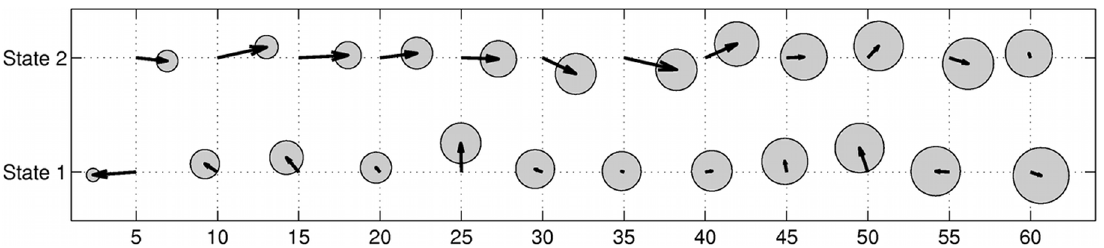
Figure 3. Posterior mean vectors of turning-angle distributions of possum # 1882. The figure shows the posterior mean vectors of the wrapped Cauchy distribution of turning angles, for each sub-sampling interval and behavioural state. Circles around each arrow head have radius equal to the posterior standard deviation of the mean vector.